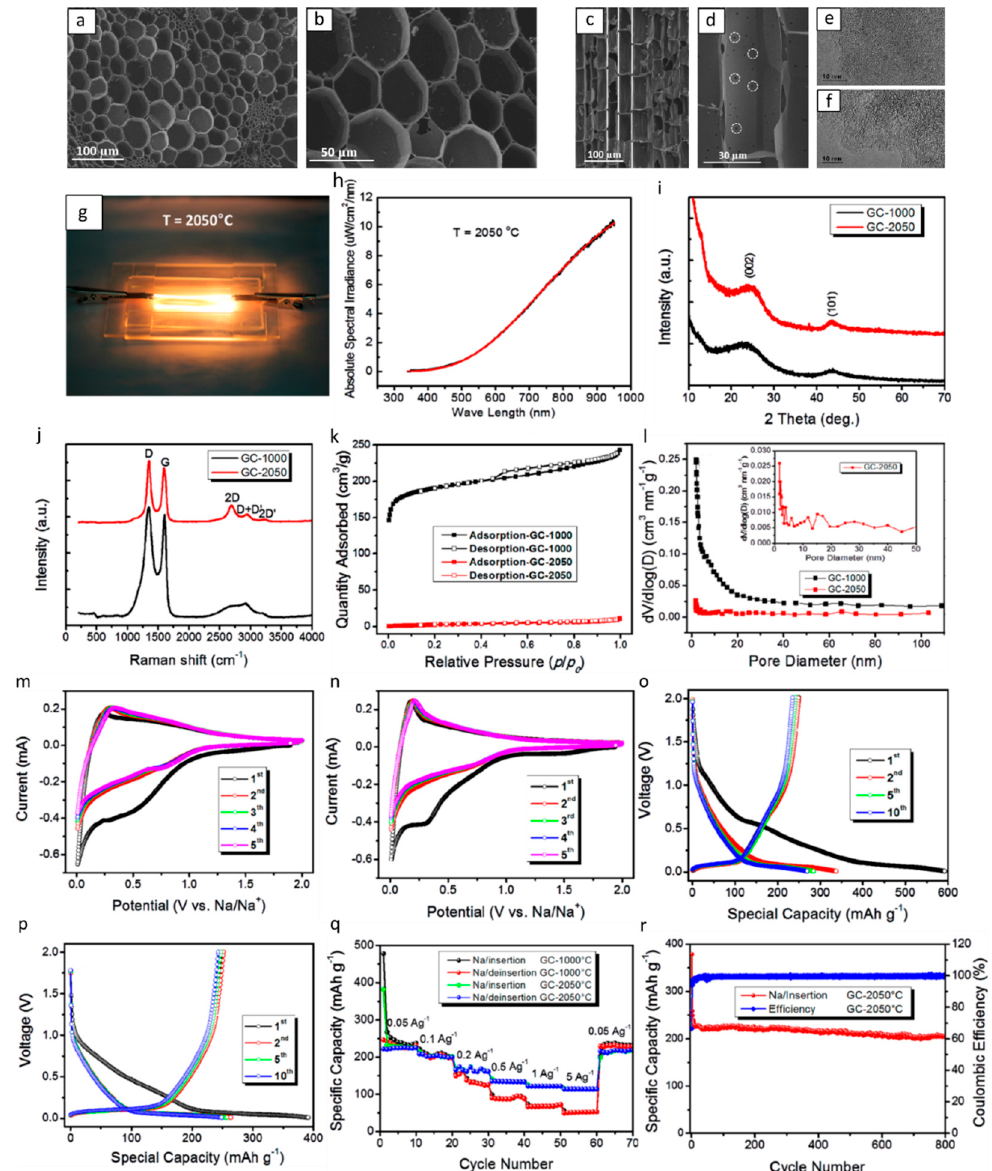
Figure 1. Structural characterization and electrochemical performance analysis of Hard Carbon (carbonized switchgrass, GC-1000 and GC-2050) as an anode in Sodium ion batteries (SIBs): ( a ) Low magnification SEM image from a cross section of GC-1000. ( b ) Corresponding higher magnification SEM image of GC-1000. ( c ) Low magnification SEM image from longitudinal section of GC-2050 where vertical lines are showing the array structure. ( d ) Higher magnification SEM image of GC-2050 where dashed circles highlight the micro / nanoscale holes for ion transport. ( e , f ) HRTEM (High-resolution transmission electron microscopy) images of GC-1000 and GC-2050. ( g ) Digital photograph of switchgrass derived carbon under Joule heating. ( h ) Light emission spectra of the carbonized switchgrass, here the temperature was fitted according to blackbody radiation equation. ( i ) XRD patterns of the GC-1000 (black) and Gc-2050 (red). Samples show identical twin broad peaks around 2 θ = 23.6 ◦ and 43.6 ◦ , corresponding to the di ff raction of graphitic layered structure. ( j ) Raman spectra of GC-1000 (black) and GC-2050 (red) confirmed the progressively ordered structure in the samples. ( k , l ) N 2 adsorption / desorption isotherms and pore size distribution of GC-1000 and GC-2050, respectively. ( m , n ) Cyclic voltammogram (CV) curves for the first five cycles of GC-1000 and GC-2050, respectively at a scanning rate of 0.5 mV s − 1 . ( o , p ) Voltage profiles of GC-1000 and GC-2050 respectively at a current density of 50 mA g − 1 in the potential range: (0.01–2 V). ( q , r ) Specific capacity, coulombic e ffi ciency, and rate capability of GC-1000 and GC-2050 samples. Reprinted with permission from [48]. Copyright 2017 American Chemical Society.